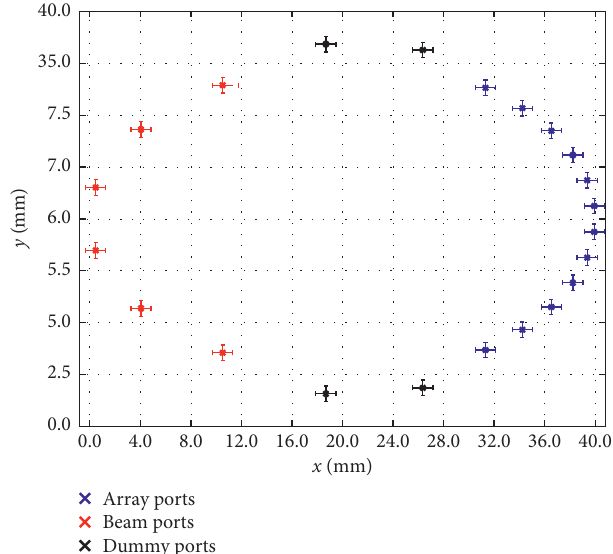
Figure 15: K-band Rotman lens: port positions and position tolerances after IA refinement.